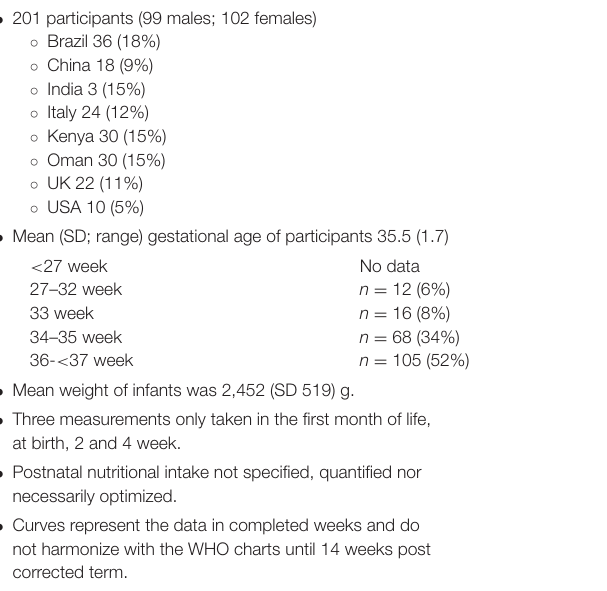
TABLE 4 | Key features of INTERGROWTH-21st postnatal preterm growth standard